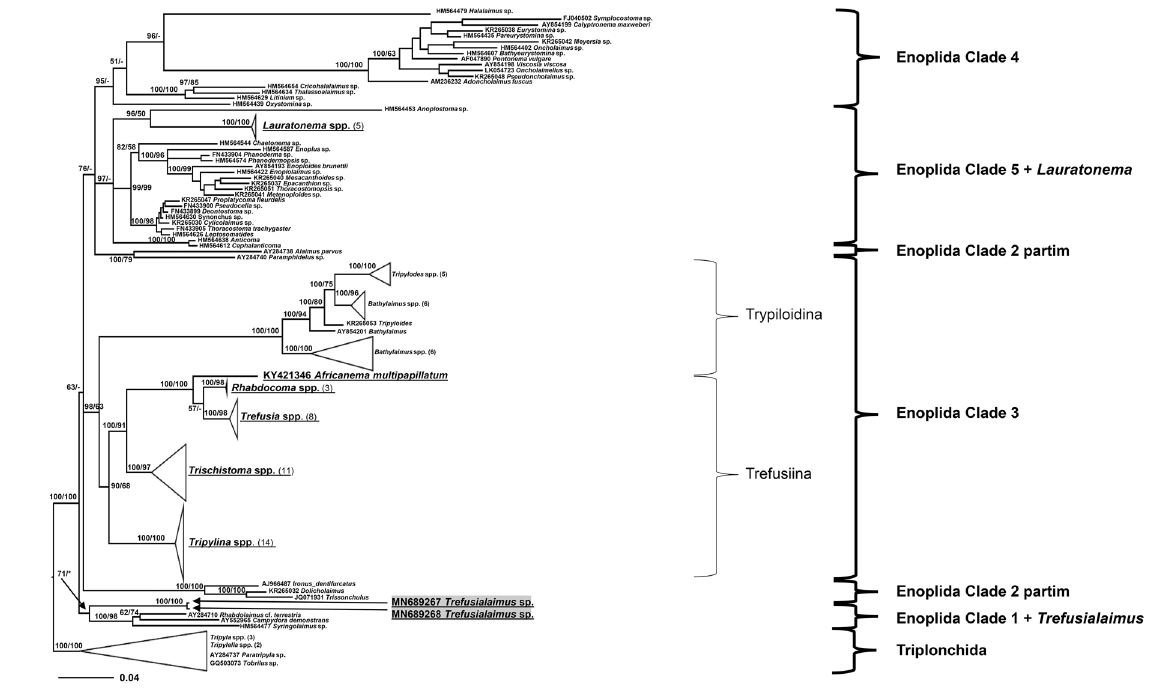
Fig. 1. Bayesian tree of the Enoplida (and Triplonchida outgroup) inferred from SSU sequences, aligned using the MUSCLE alignment algorithm and with regions of questionable alignment removed using Gblocks, under the general time-reversible (GTR) + proportion of invariable sites (I) + gamma distribution (G) model. Trefusiina sequences are shown in underlined font, and new Trefusialaimus sequences are highlighted in grey. The five enoplid clades described by Bik et al. (2010) are identified on the right. Posterior probability (left) and bootstrap values (right) are given on corresponding clades. Dashes (-) indicate no support and aserisks (*) indicate <50% support. The scale stands for substitutions per